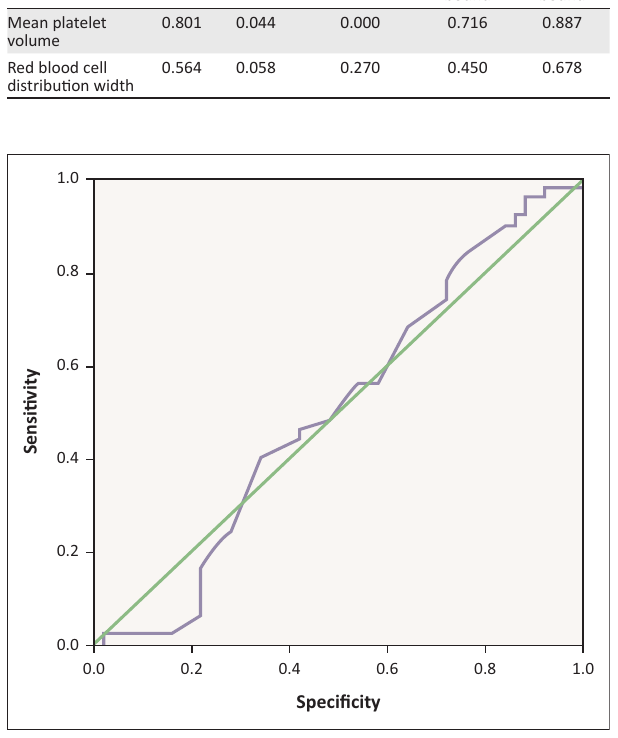
FIGURE 3: Receiver operating characteristic curve analysis to evaluate mean platelet volume utility in discriminating between irritable bowel syndrome and inflammatory bowel disease patients, Babol, Iran, 2015–2017.